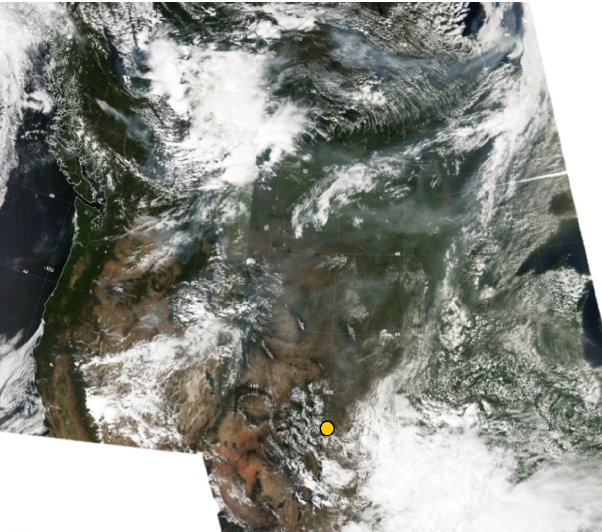
Figure 10. MODIS Aqua true color images of much of North Amer- ica on 17 July 2014, composited from four granules at 19:45, 19:50, 21:25, and 21:30UT. The approximate location of the HSRL-2 ob- servations discussed in the text (Denver, Colorado) is marked with a yellow dot. The bright white is clouds and snow cover and the gray is smoke. Several distinct smoke plumes indicate sources in the US Pacific Northwest and in western Canada within the cloud-free area on the western part of the continent. Significant smoke layers from these fires blanket the mid-continent cloud-free areas in the north- ern portion of the image. The HSRL-2 measurements are close to the southern edge of the extensive smoke field.